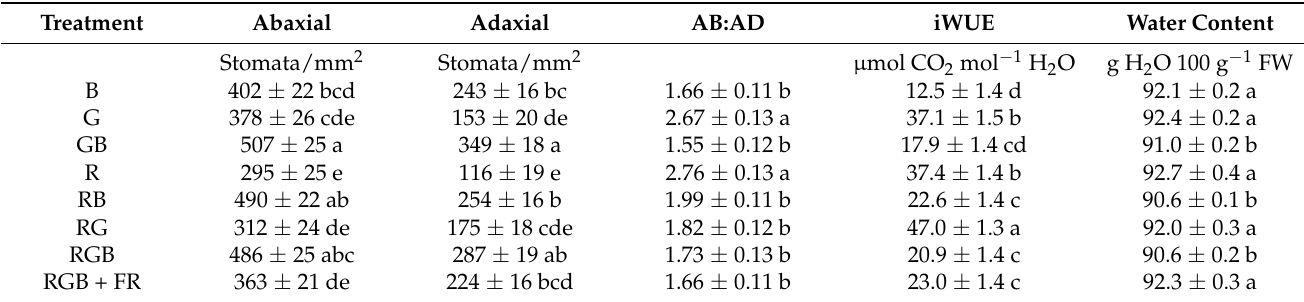
Table 3. Stomatal density, abaxial (AB) to adaxial (AD) stomatal density ratio, intrinsic water use efficiency, and water content of